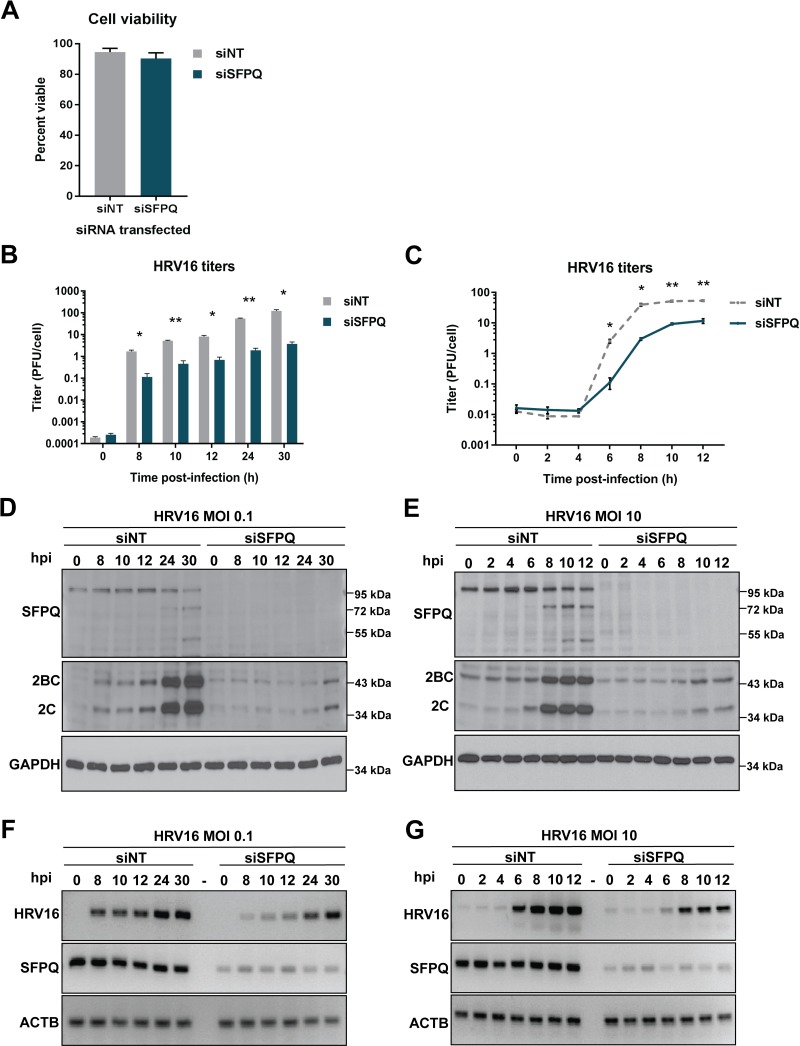
SFPQ knockdown correlates with reduced HRV16 replication.(A) Transfection of non-targeting siRNA (siNT) or SFPQ-targeting siRNA (siSFPQ) did not result in statistically significant differences in cell viability 96 h post-transfection, as assessed by trypan blue exclusion prior to infection (P > 0.05). Mean percent viable values are displayed with error bars representing one standard deviation. (B) HeLa cells transfected with siRNA for 96 h were infected with HRV16 (MOI 0.1) and cells and cell culture fluids were harvested at the indicated times. Virus titer was determined by plaque assay. Data represent the means of three biological replicate experiments with error bars indicating standard error of the means (SEM) (* P < 0.005, ** P < 0.0005). (C) Single cycle growth analysis of HRV16 from siRNA-transfected and HRV16-infected HeLa cells (MOI 10). As in panel B, data represent the means of three biological replicate experiments with error bars displaying SEM (* P <0.005, ** P <0.0005). (D) siRNA-transfected and HRV16-infected HeLa cell lysates corresponding to the time-points in panel B (MOI 0.1) were generated and subjected to Western blot analysis. Knockdown of SFPQ was confirmed and levels of 2C and precursor (2BC) represented viral protein production. GAPDH was used as a loading control. (E) Western blot analysis of lysates from siRNA-transfected and HRV16-infected HeLa cells corresponding to time points in panel C (MOI 10). Western blots in panels D and E are representative results from three biological replicate experiments. (F) RNA isolated from siRNA-transfected and HRV16-infected HeLa cells at time-points corresponding to panel B (MOI 0.1) was subjected to RT-PCR. Primers for PCR were specific for HRV16 RNA, SFPQ mRNA, or actin (ACTB) mRNA. PCR products were separated by agarose gel electrophoresis. (G) RT-PCR analysis of RNA isolated from siRNA-transfected and HRV16-infected HeLa cells at time-points corresponding to panel C (MOI 10). Data in panels F and G are representative results from biological duplicate experiments. hpi: hours post infection.